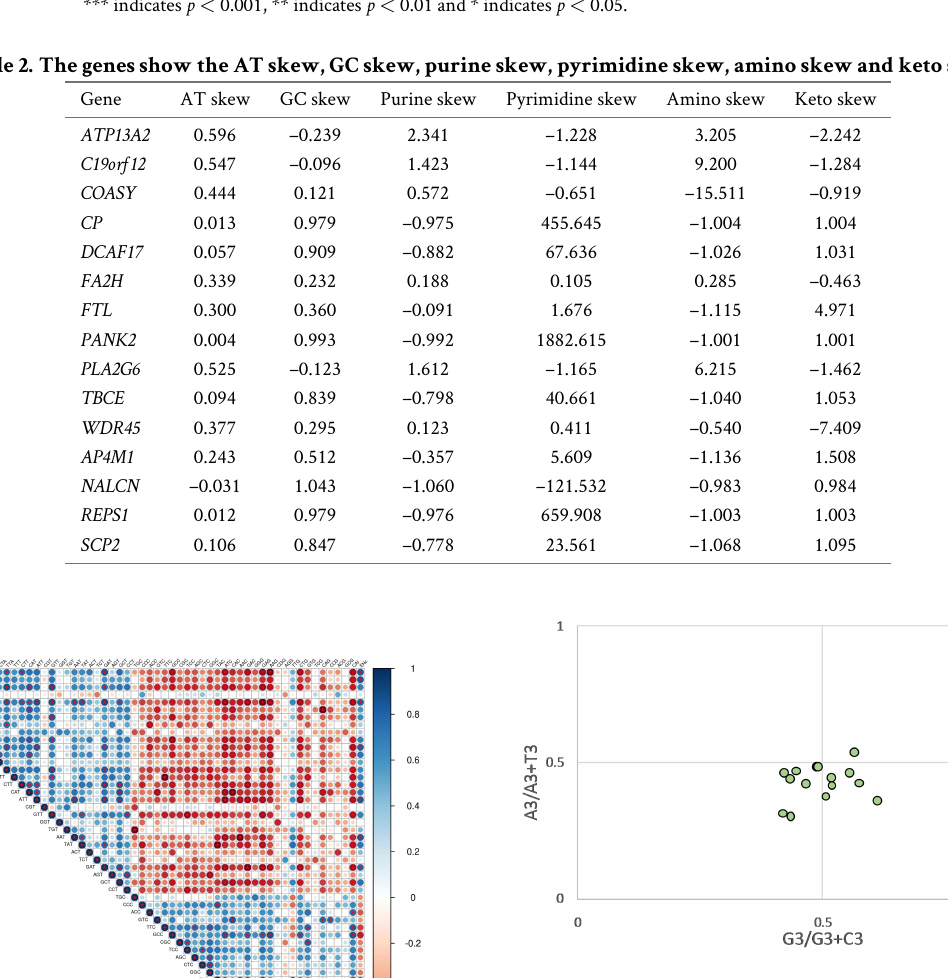
Fig. 6. Parity plot showing AT and GC bias at third codon position. The results indicate the preference of T and C over A and G, respec- tively. On X-axis, GC bias is displayed, while on the Y axis, AT bias is dis-